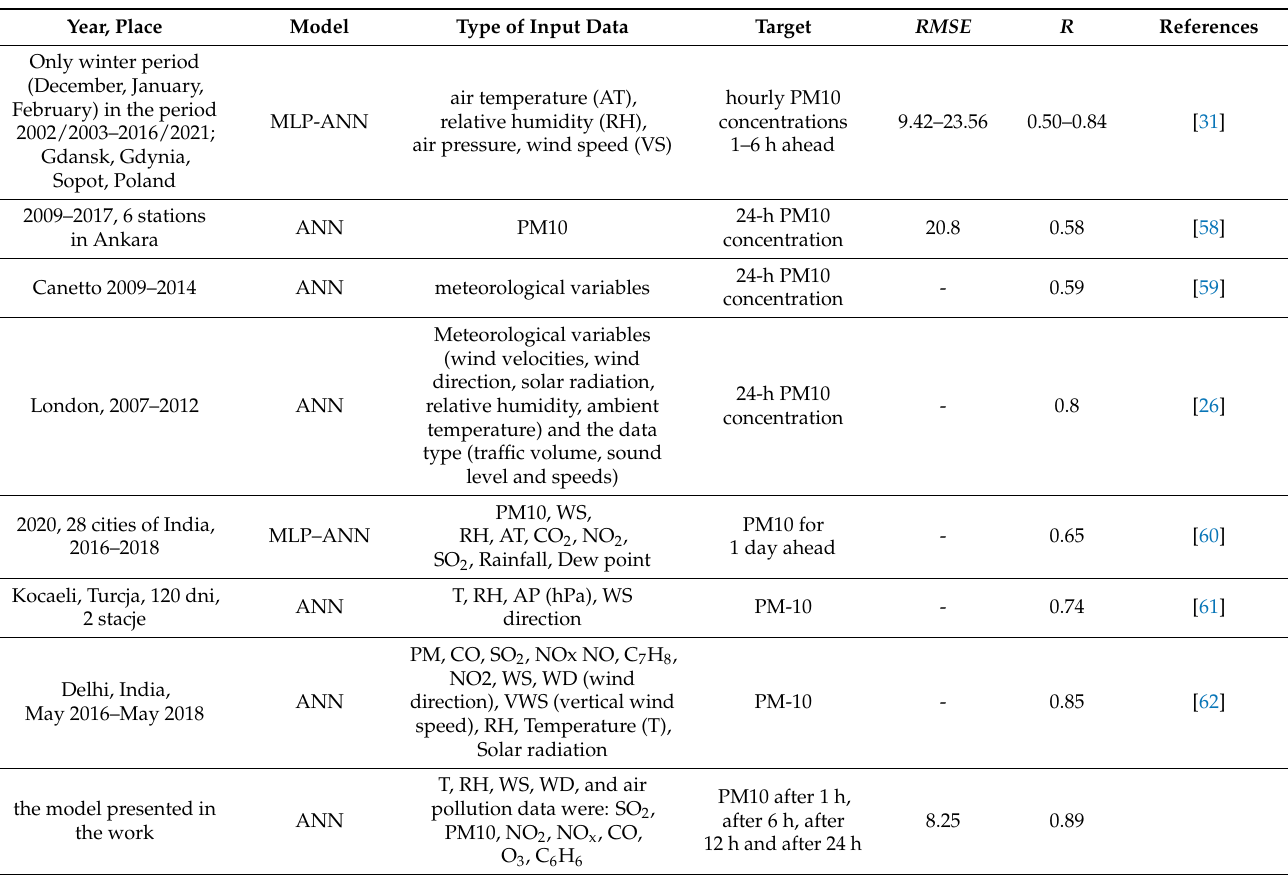
Table 11. Comparison with other ANN